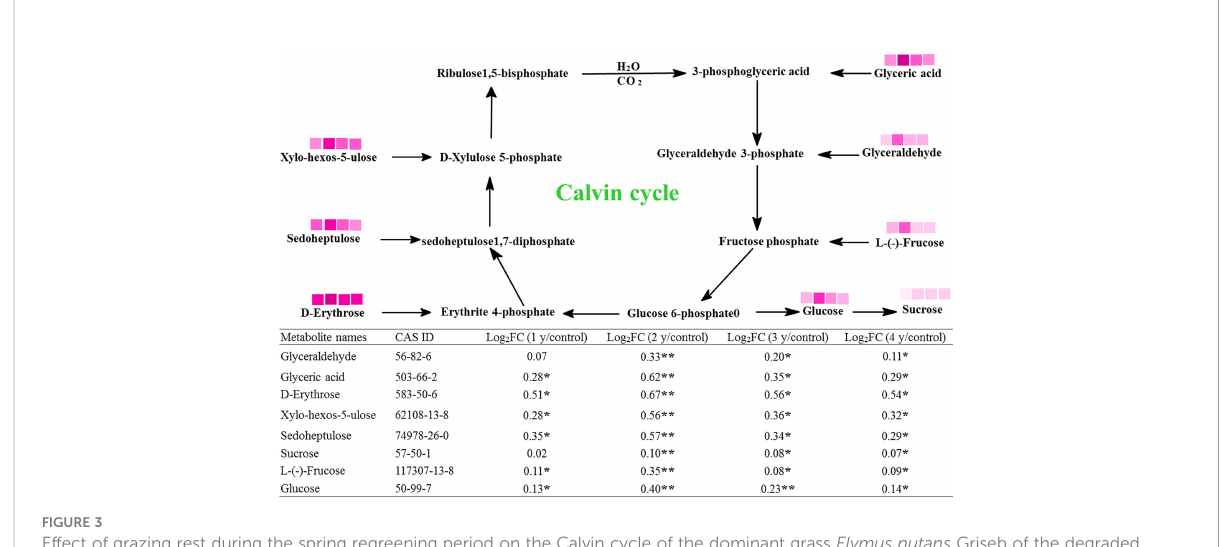
FIGURE 3 Effect of grazing rest during the spring regreening period on the Calvin cycle of the dominant grass Elymus nutans Griseb of the degraded alpine meadow vegetation. FC, fold change of relative content; *signi fi cant difference at P = .05; **signi fi cant difference at P = .01 represent log 2 FC ≤ 0.7, ≤ 0.6, ≤ 0.5, ≤ 0.4, ≤ 0.3, ≤ 0.2, ≤ 0.1, and ≤ 0.05,